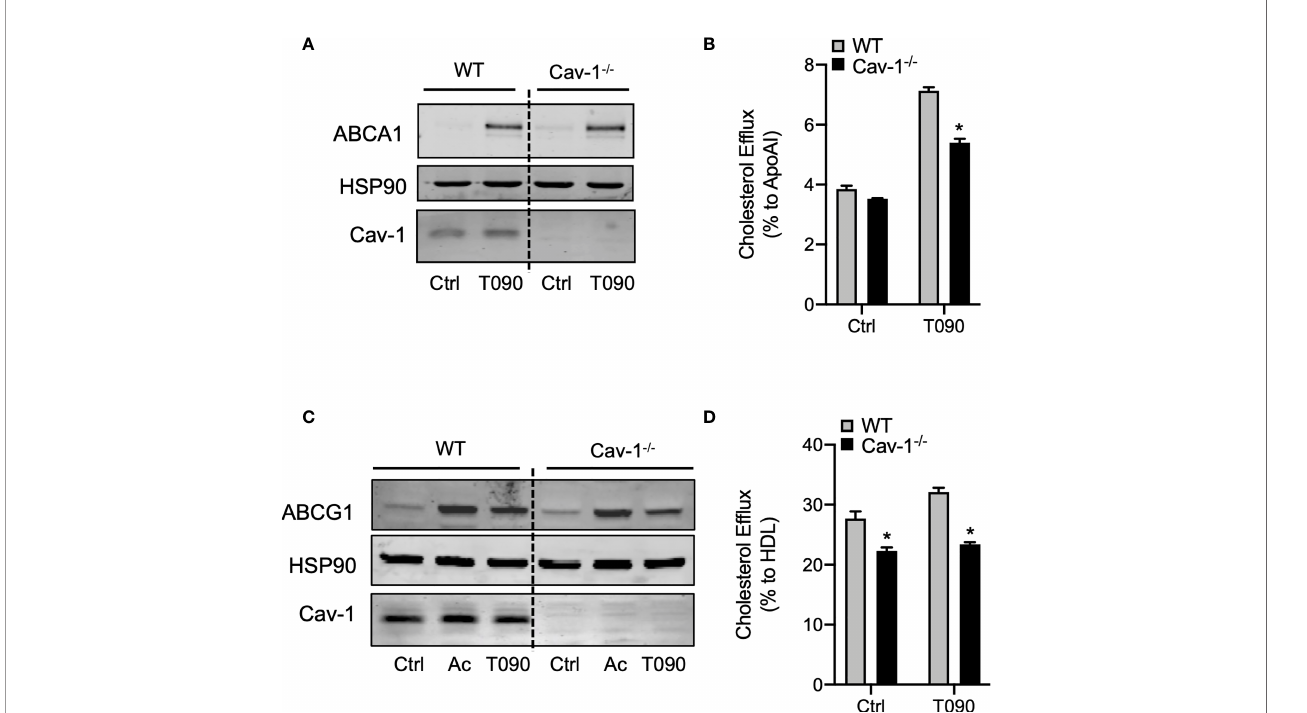
FIGURE 6 | Cav-1 in fl uences subcellular distribution of ABCA1 and modulates ABCA1-dependent cholesterol ef fl ux. (A) Western blot analysis of ABCA1 in peritoneal macrophages from WT and Cav-1 -/- mice treated with or without or 1 m M T0901317 (T090) for 18 hours. Cav-1 was used to show its absence in the Cav-1 -/- mice and HSP90 was used as a loading control. Experiment was performed at least 3 times. (B) Cholesterol ef fl ux to apolipoprotein A1 (ApoA1) in peritoneal macrophages isolated from WT and Cav-1 -/- mice stimulated with or without 3 m M of T090 for 16 hours. Data represent the mean ± SEM of triplicate samples (n = 3 per group; P<0.05 , (signi fi cantly different from WT in each treatment condition). (C) Western blot analysis of ABCG1 in peritoneal macrophages from WT and Cav-1 -/- mice treated with or without or 1 m M T0901317 (T090) for 18 hours. Cav-1 was used to show its absence in the Cav-1 -/- mice and HSP90 was used as a loading control. Experiment was performed at least 3 times. (D) Cholesterol ef fl ux to HDL in peritoneal macrophages isolated from WT and Cav-1 -/- mice stimulated with or without 3 m M of T090 for 16 hours. Data represent the mean ± SEM of triplicate samples (n = 3 per group; P<0.05 , (signi fi cantly different from WT in each treatment condition). * P <